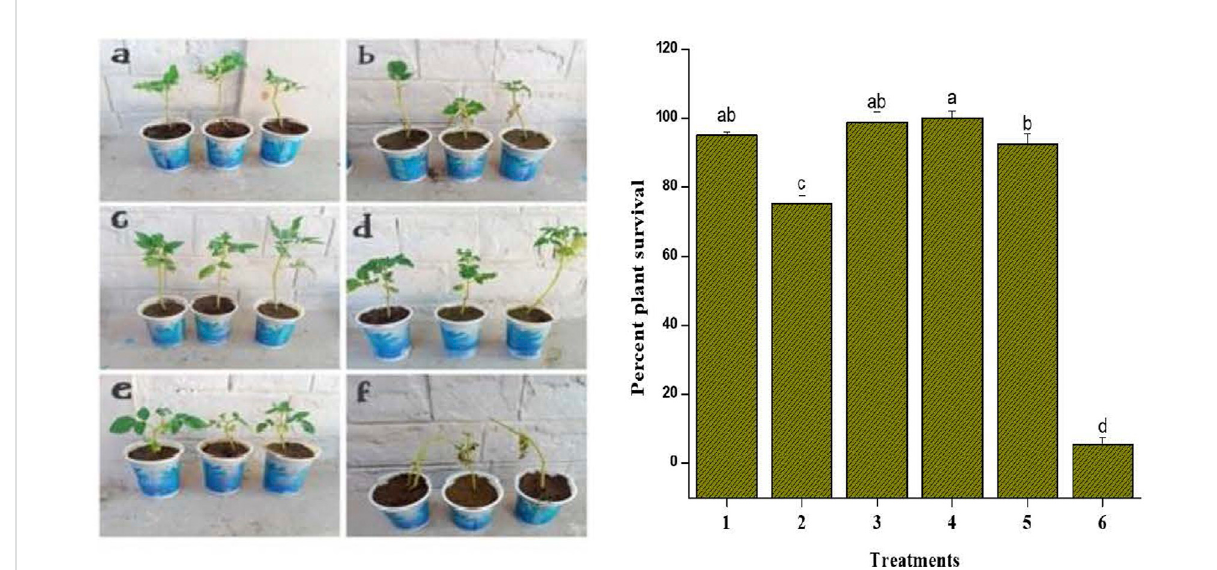
FIGURE 8 InplantatreatmentsagainstF.oxysporum.BargraphshowingplantsurvivalpercentaftertheinoculationofF.oxysporum.Treatmentsincluded: